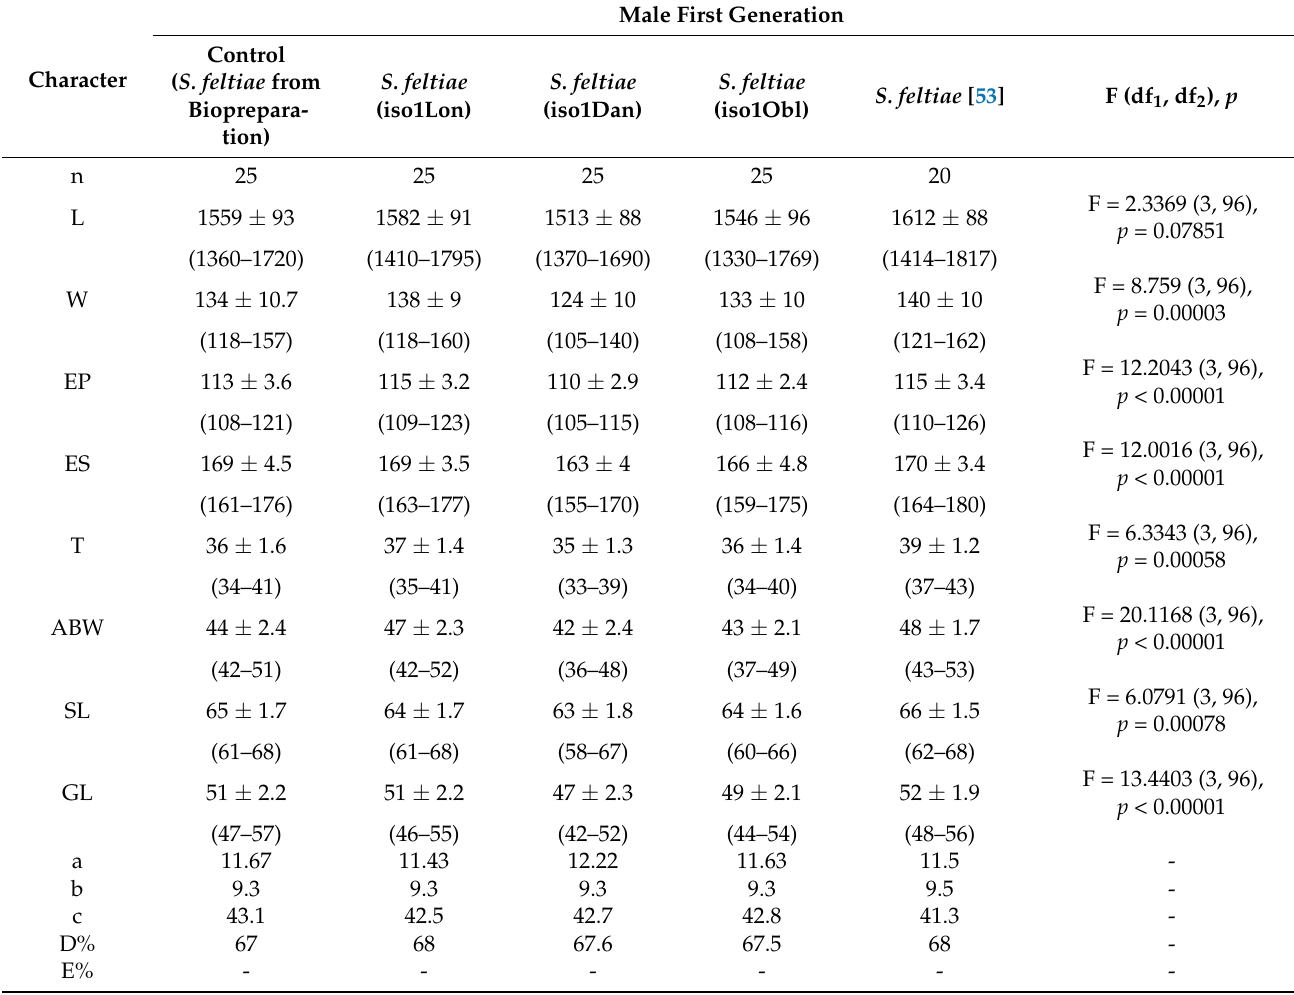
Table 2. Morphometric variables (mean ± SD) of first-generation adult males of Steinernema feltiae from Poland. Variables (in µ m) are analyzed by one-way ANOVA with correspondent F statistic, with degrees of freedom and p